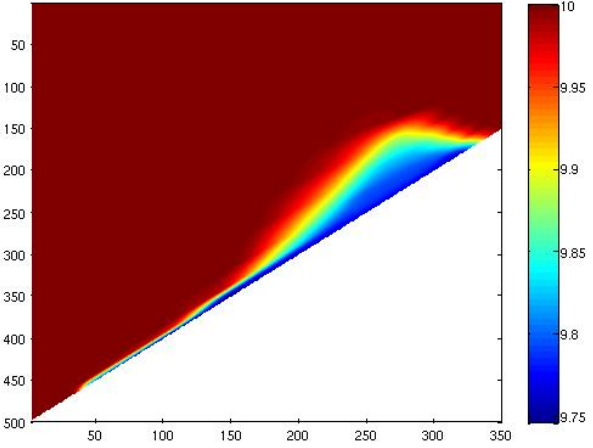
Fig. 7. Temperature structure (in C ◦ ) in simulation (G11) after 7 days. Coordinates give grid levels.